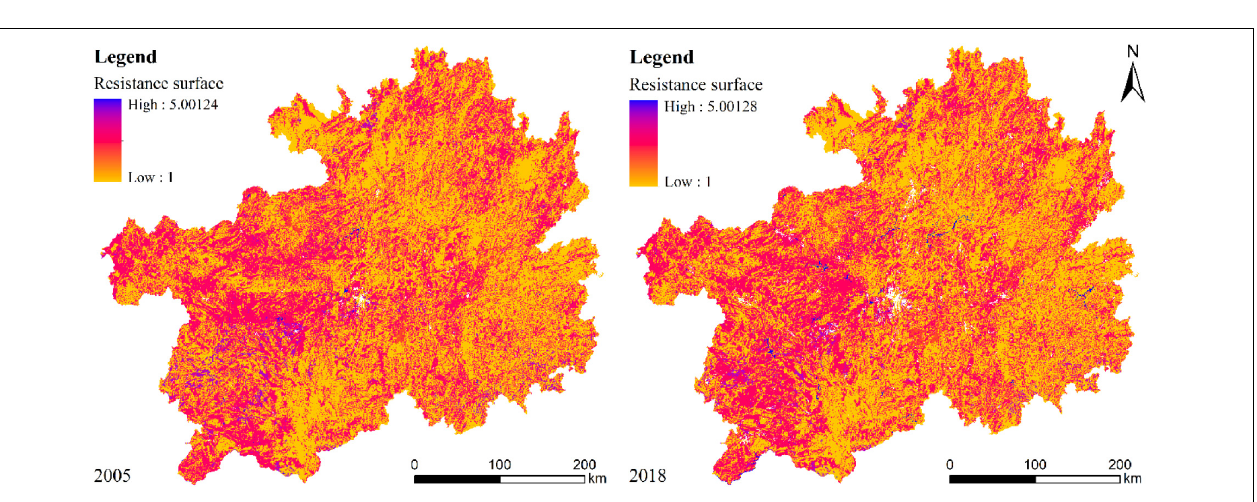
FIGURE 4 | Spatial distributions of resistance surfaces in 2005 and 2018.